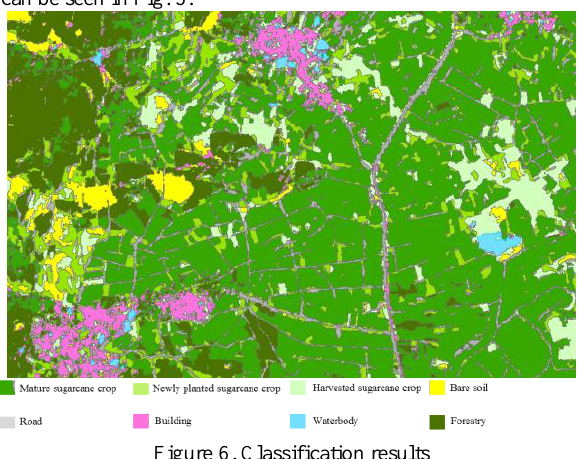
Figure 6. Classification results